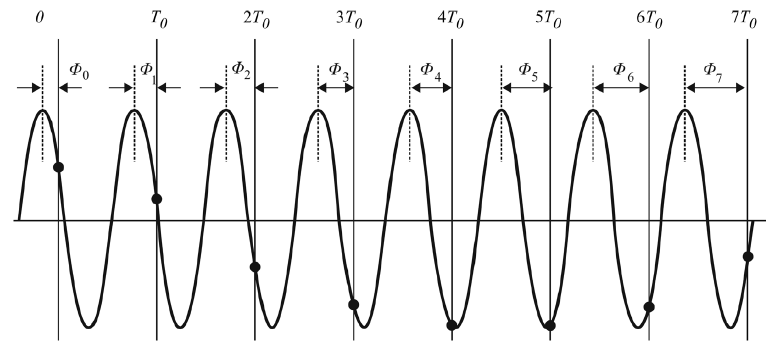
Figure 5. A sinusoid with a frequency f, after the Pulse Per Second (PPS), is observed with a reporting time of T 0 seconds.